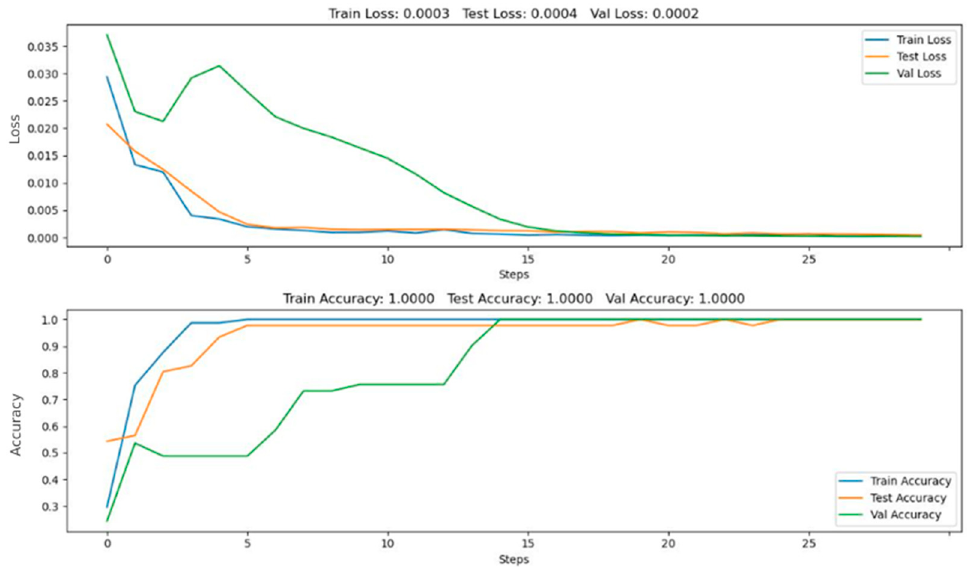
Figure 11. An example of the training results.